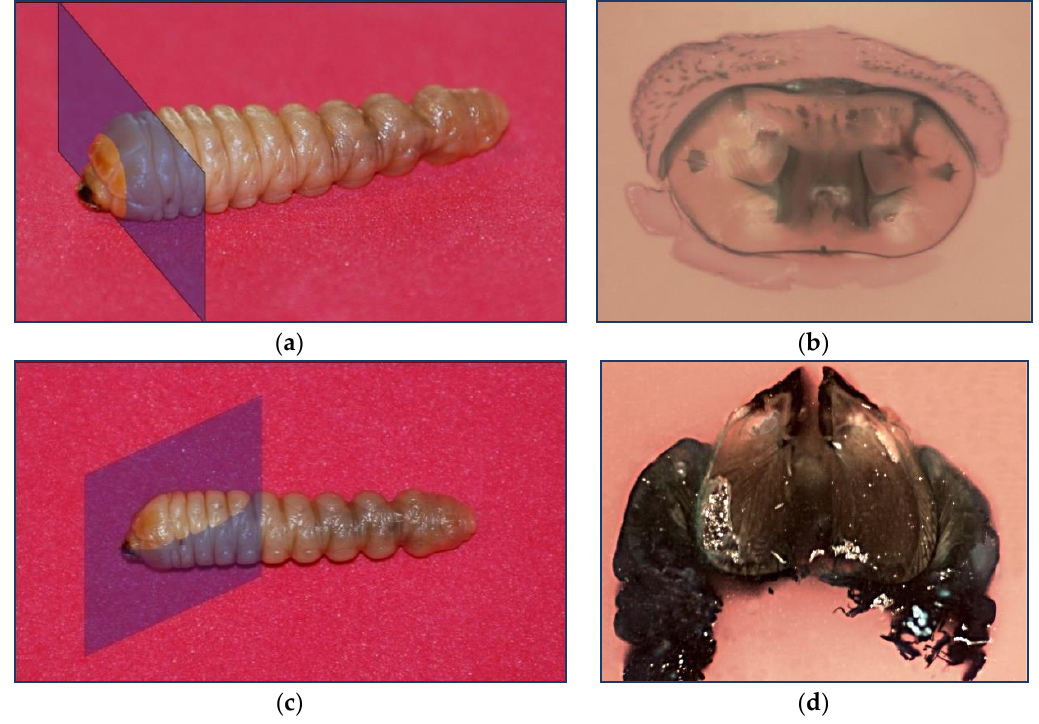
Figure 2. Larvae cutting analysis. ( a ) Cut perpendicular to the musculature. Plane where the cut was made; ( b ) resulting cut; ( c ) mandible profile. Plane where the cut was made; ( d ) resulting cut.